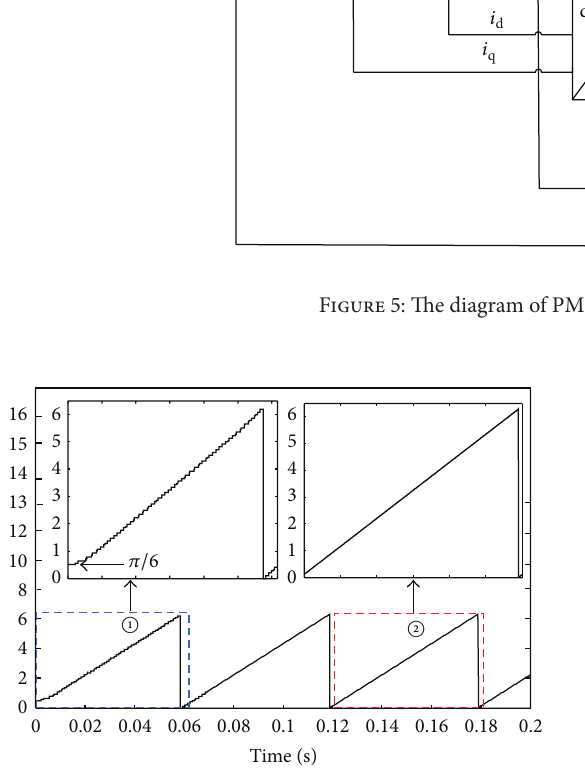
Figure 6: Waveform of mechanical angle of PMSM rotor. Figure 7: The simulation waveform of 𝐶